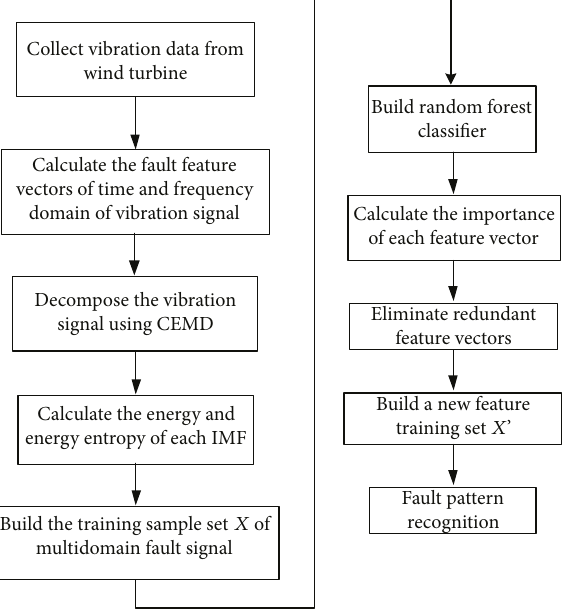
Figure 1: Flow chart of multidomain fault diagnosis based on